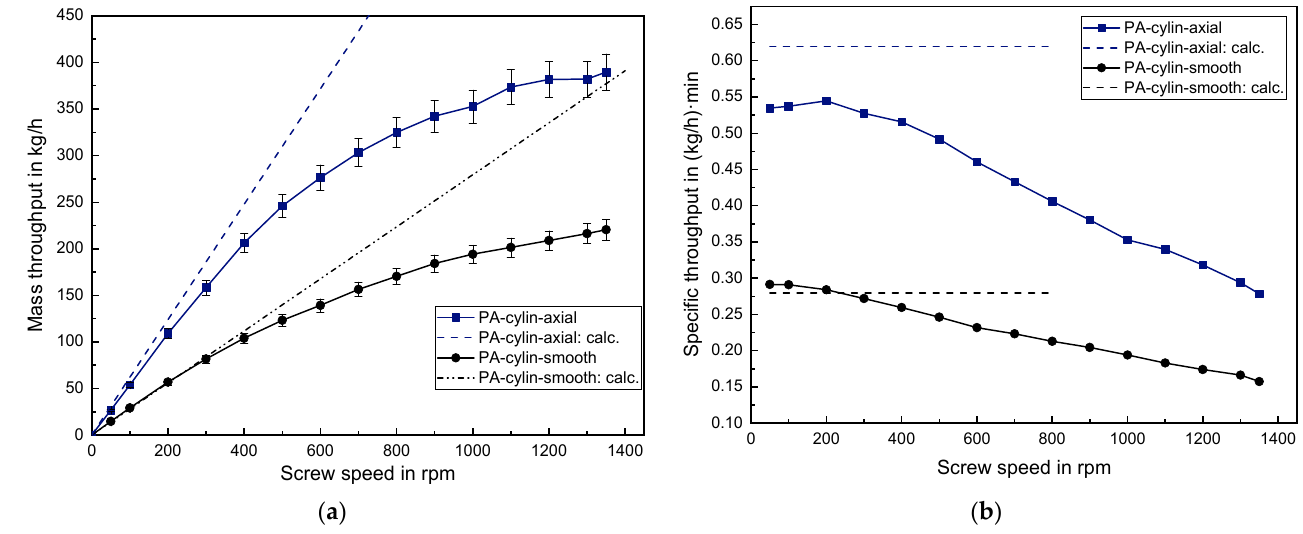
Figure 11. ( a ) Absolute mass throughput and ( b ) specific mass throughput for cylindrical PA. 3.5. Comparing the Results of the Mere Solid Conveying Zone to an Entire Extruder Set-Up including Melting